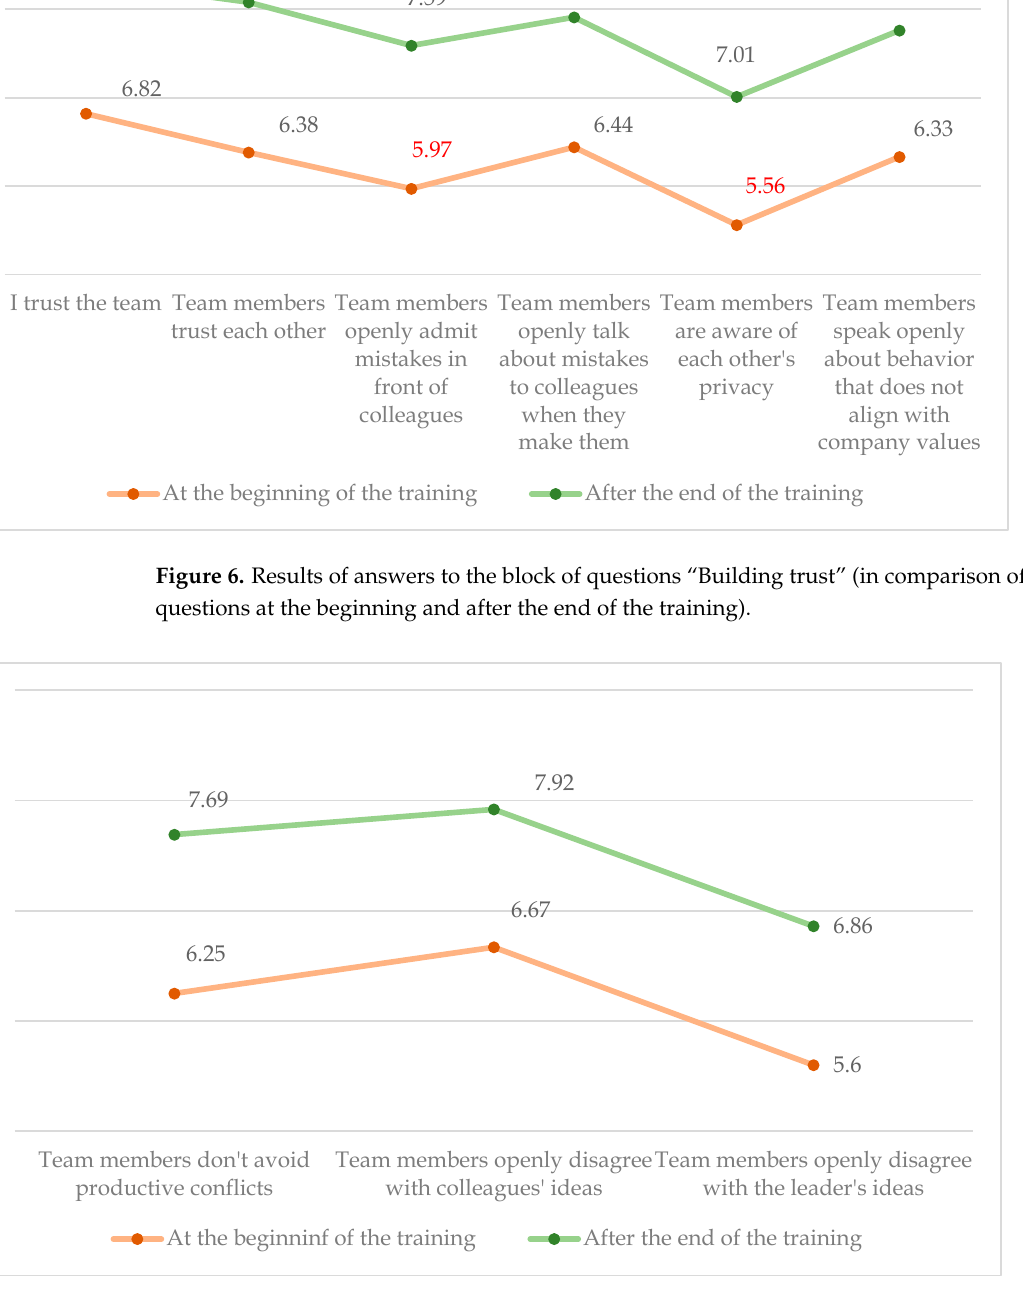
Figure 7. Results of answers to the block of questions “Translation of the conflict into a productive way of finding ideas and optimal solutions” (in comparison of answers to questions at the beginning and after the end of the training).